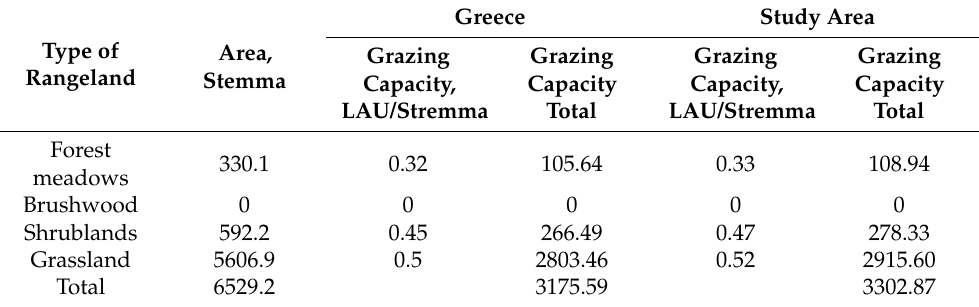
Table 4. Types of meadows and grazing capacity in the pasture of